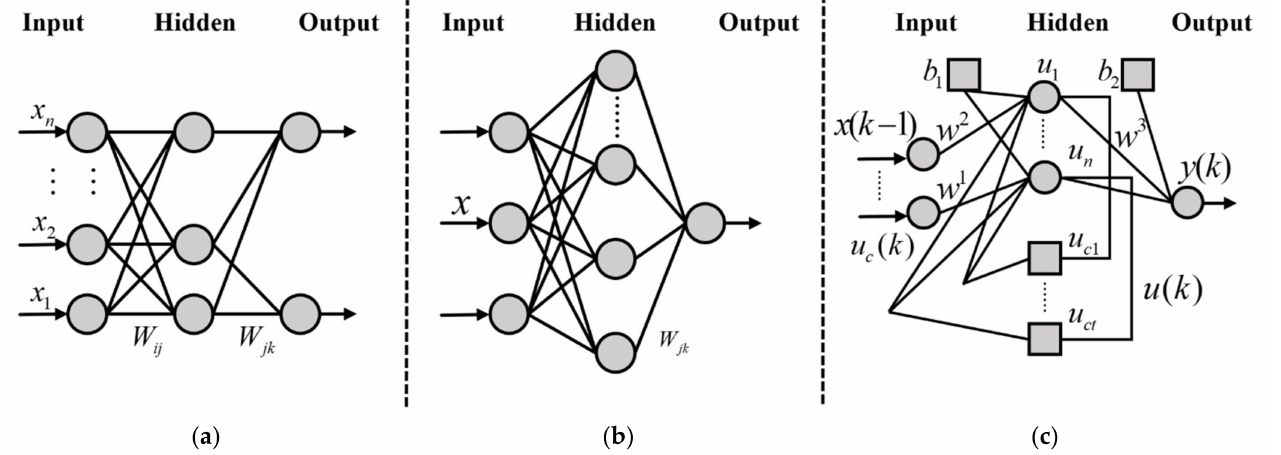
Figure 5. The structure diagrams of the three algorithms. ( a ) BPNN algorithm, ( b ) ELM algorithm, and ( c ) Elman